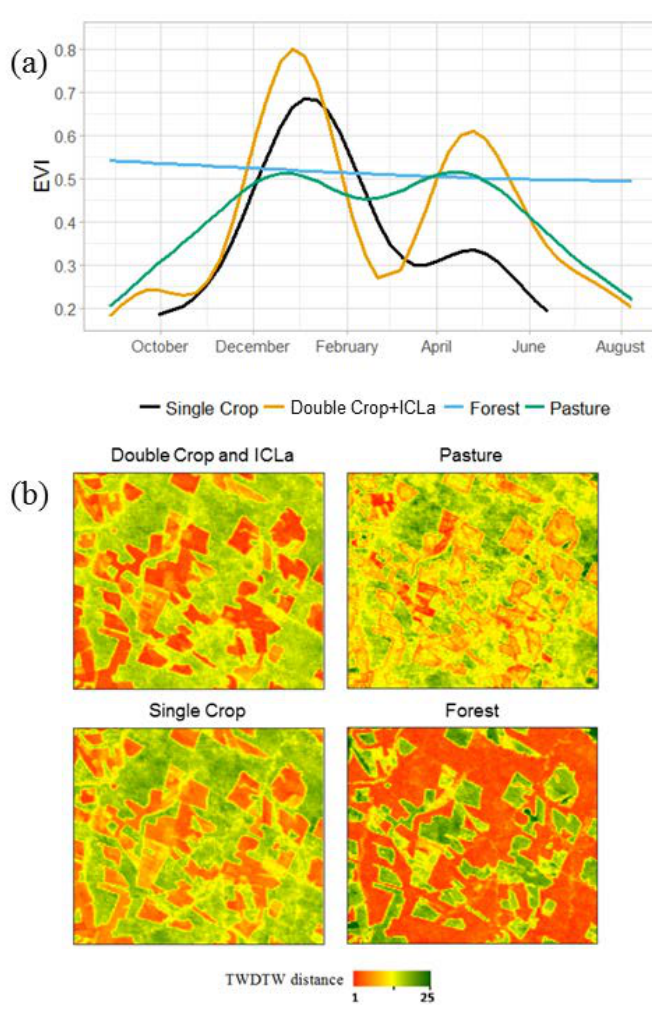
Figure 4. ( a ) Temporal patterns and ( b ) TWDTW distance subset for classes in Phase 1. Note: TWDTW, Time-Weighted Dynamic Time Warping.